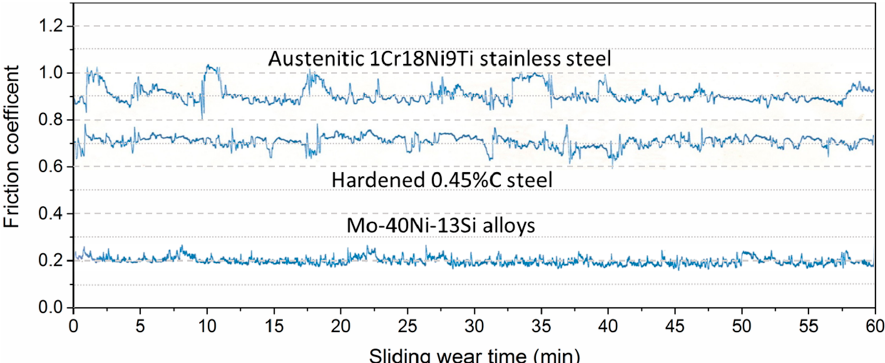
Figure 5. Friction coefficient profiles of the Mo–40Ni–13Si alloys and reference test materials as a function of wear time under 147 N applied load.